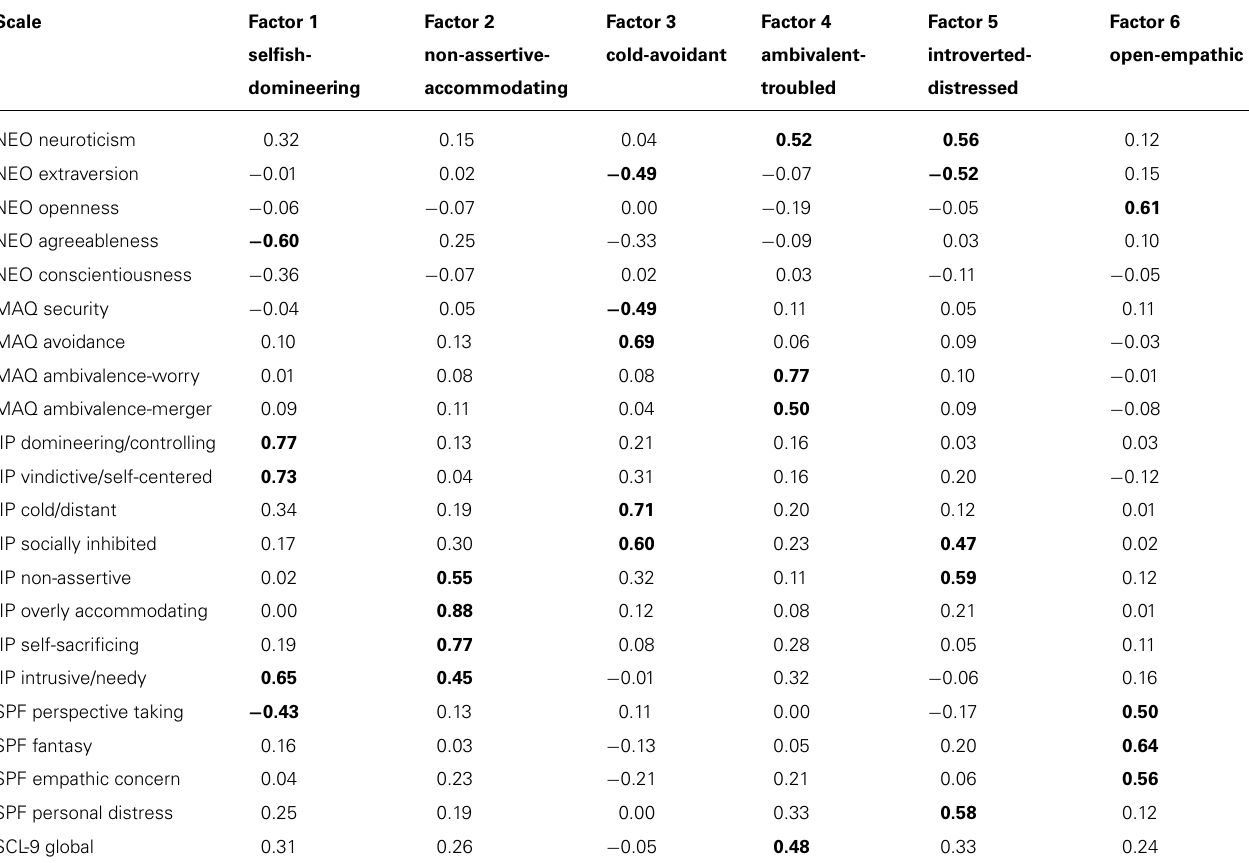
Table 1 | Factor loadings after factor analysis withVarimax rotation of 22 questionnaire